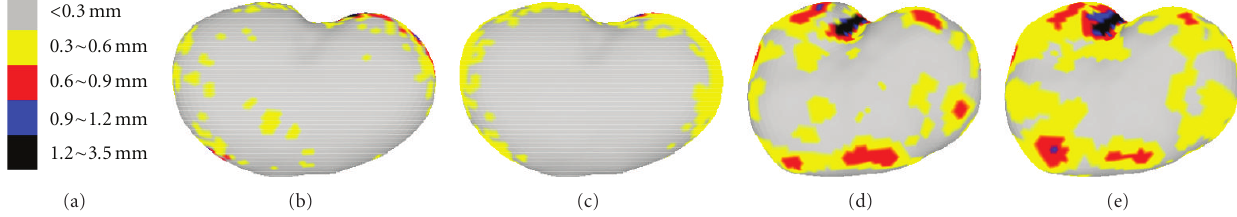
Figure 20: Representation error in intermodel Ex2: (a) color-coded scales, (b) example of color-coded point error in training set, (c) 90% color-coded point error in training set, (d) example of color-coded point error in testing set, and (e) 90% color-coded point error of testing set.